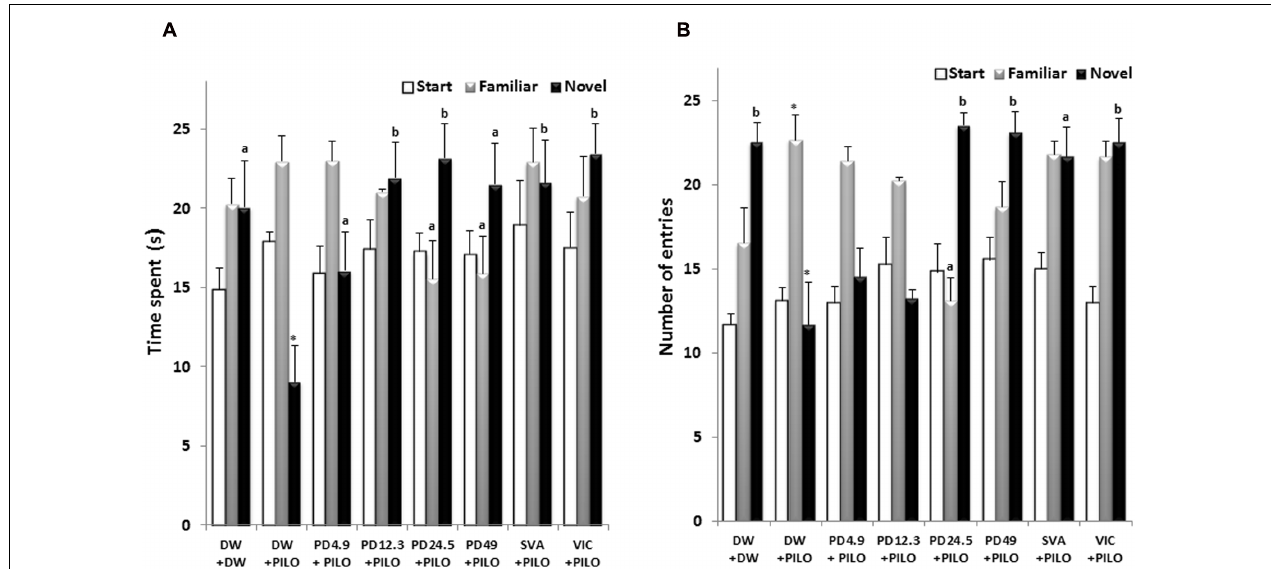
FIGURE 3 | Effects of P. daemia on T-maze parameters. (A) Effects of P. daemia on the time spent in the start, novel and familiar T-maze. (B) Effect of P. daemia on the number of entries in start, novel and familiar T-maze arms. Data are mean ± SEM, N = 7 per group. Newman Keul’s multiple comparisons post hoc test, with Mann–Whitney U test correction: (i) vs. control animals (DW + DW group) receiving only distilled water: ∗ p < 0.05; (ii) vs. disease control animals (DW + PILO group) receiving distilled water and pilocarpine: a p < 0.05, b p < 0.01. DW, distilled water; PD, Pergularia daemia ; PILO, pilocarpine; VIC, vitamin C; SVA, sodium